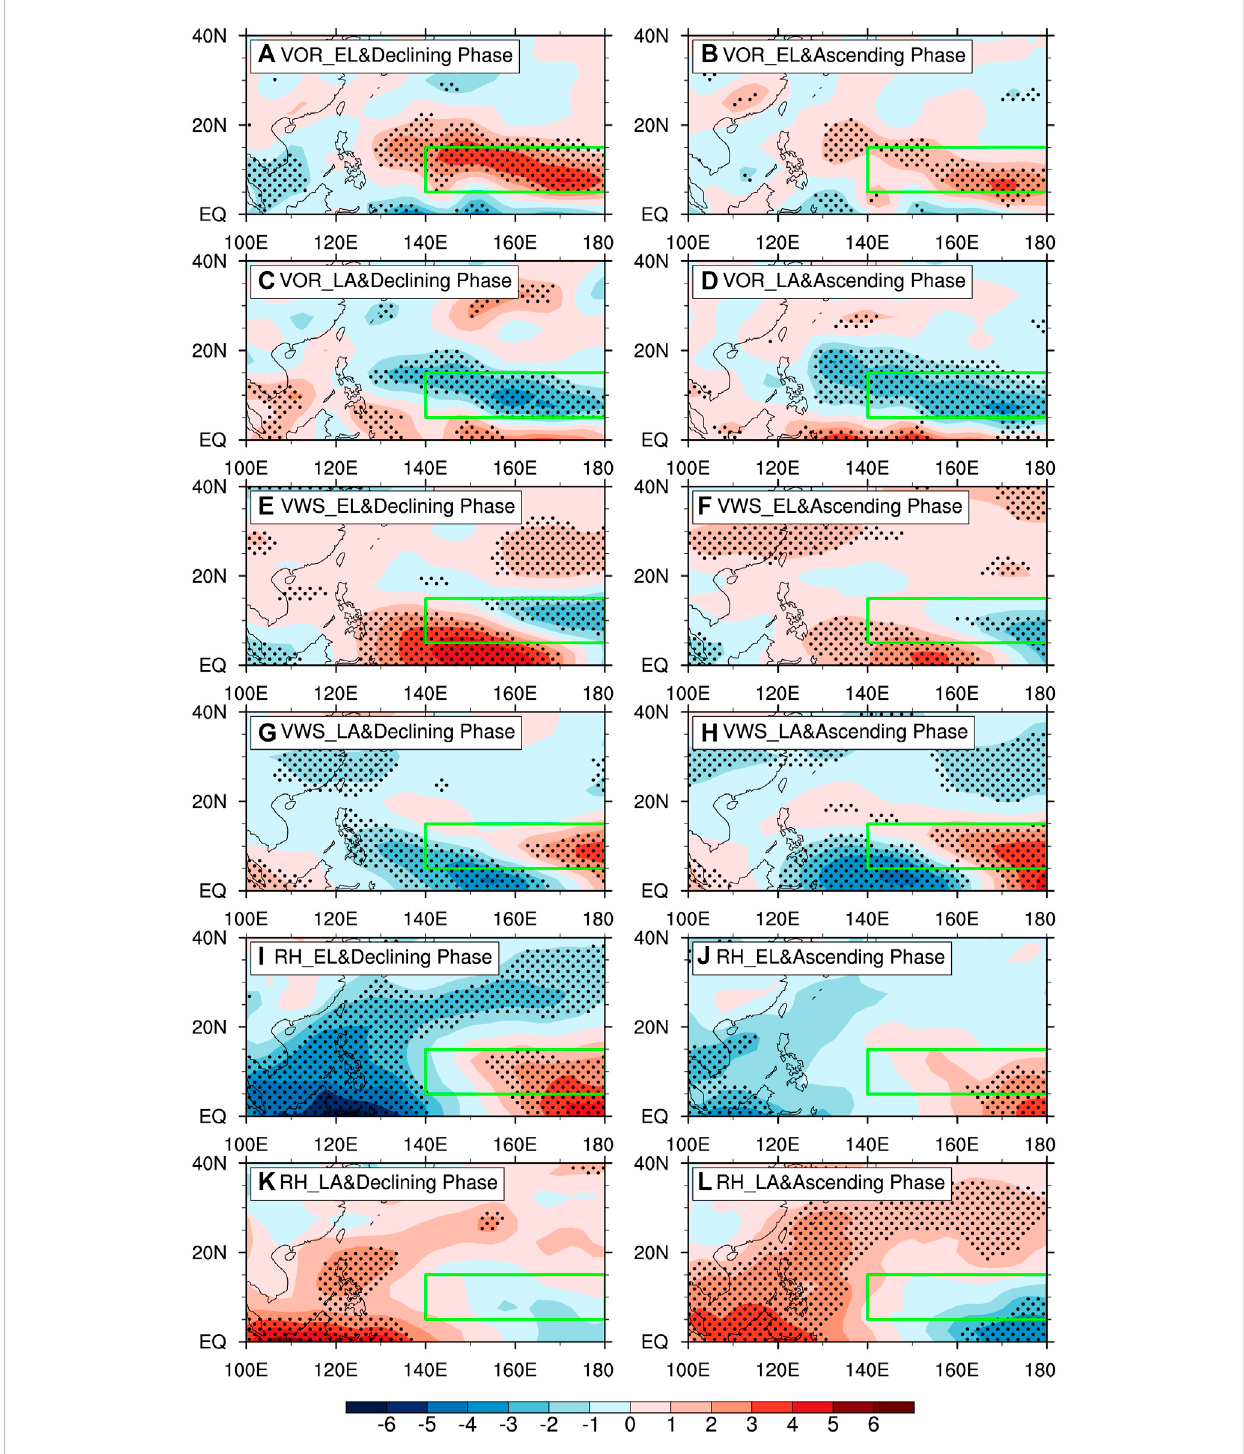
FIGURE 8 Composite (A – D) relative vorticity anomalies (units: 10 – 6 s − 1 ), (E – H) vertical wind shear anomalies between 200 hPa and 850 hPa (units: m s − 1 ), and (I – L) relative humidity anomalies at 600 hPa (units: %) in JJASON during ENSO in different solar cycle phases. Dots indicate statistical signi fi cance at the 99% con fi dence